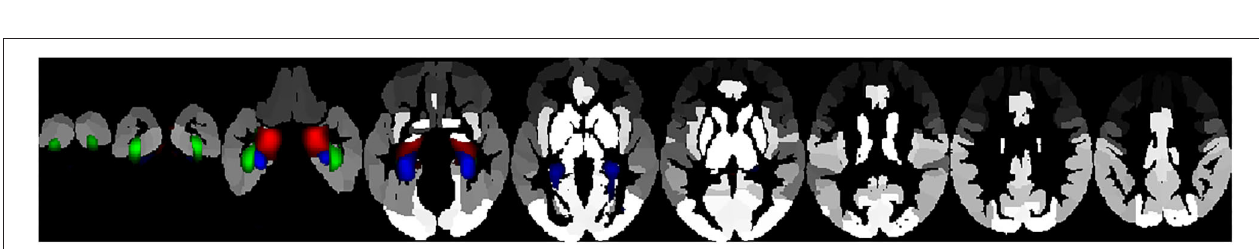
FIGURE 2 | Structural networks accounting for significant variability in the MAAS score projected on the automated anatomic labeling (AAL) atlas. Green: bilateral fusiform gyrus, Blue: bilateral parahippocampal gyrus, Red: bilateral hippocampus.